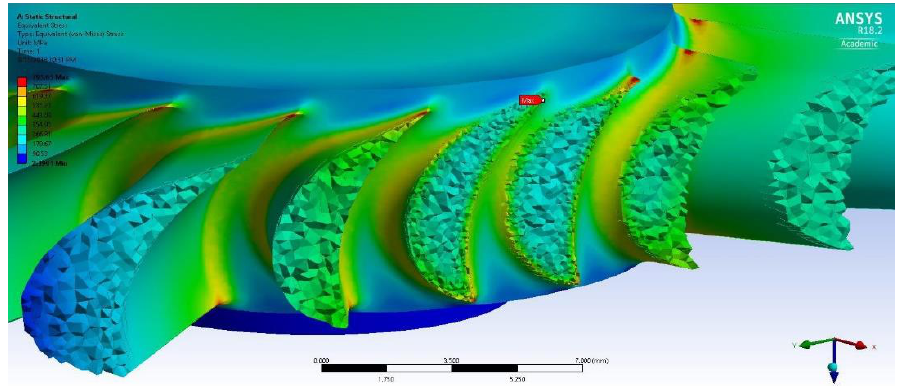
Figure 44. Blade root stress sections. Appl. Sci. 2020 , 10 , x FOR PEER REVIEW